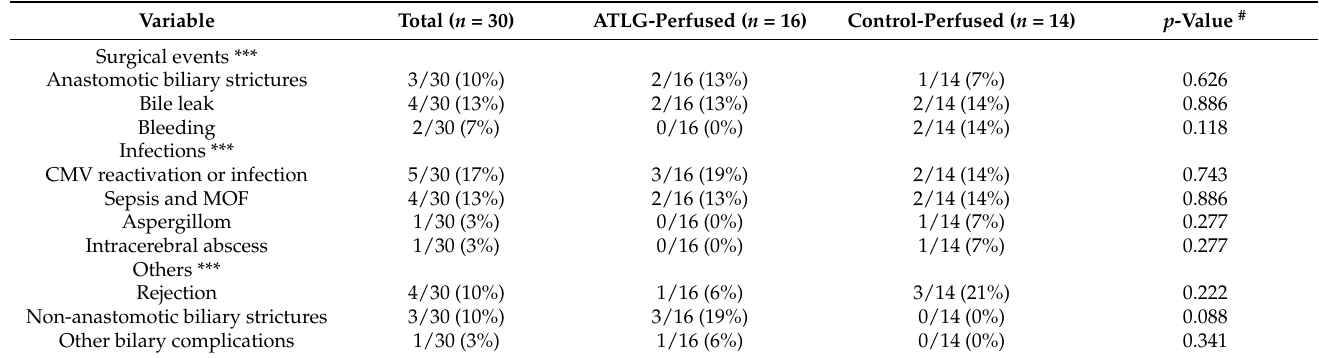
Table 2. Adverse